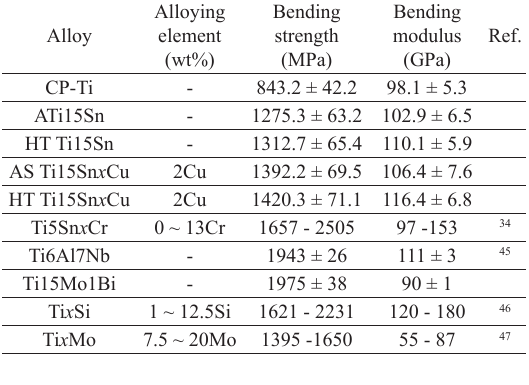
Figure 3. XRD patterns of the Ti15Sn x Cu alloys 23,36 . Table 1. Bending property of Ti15Sn x Cu under different treatment condition.